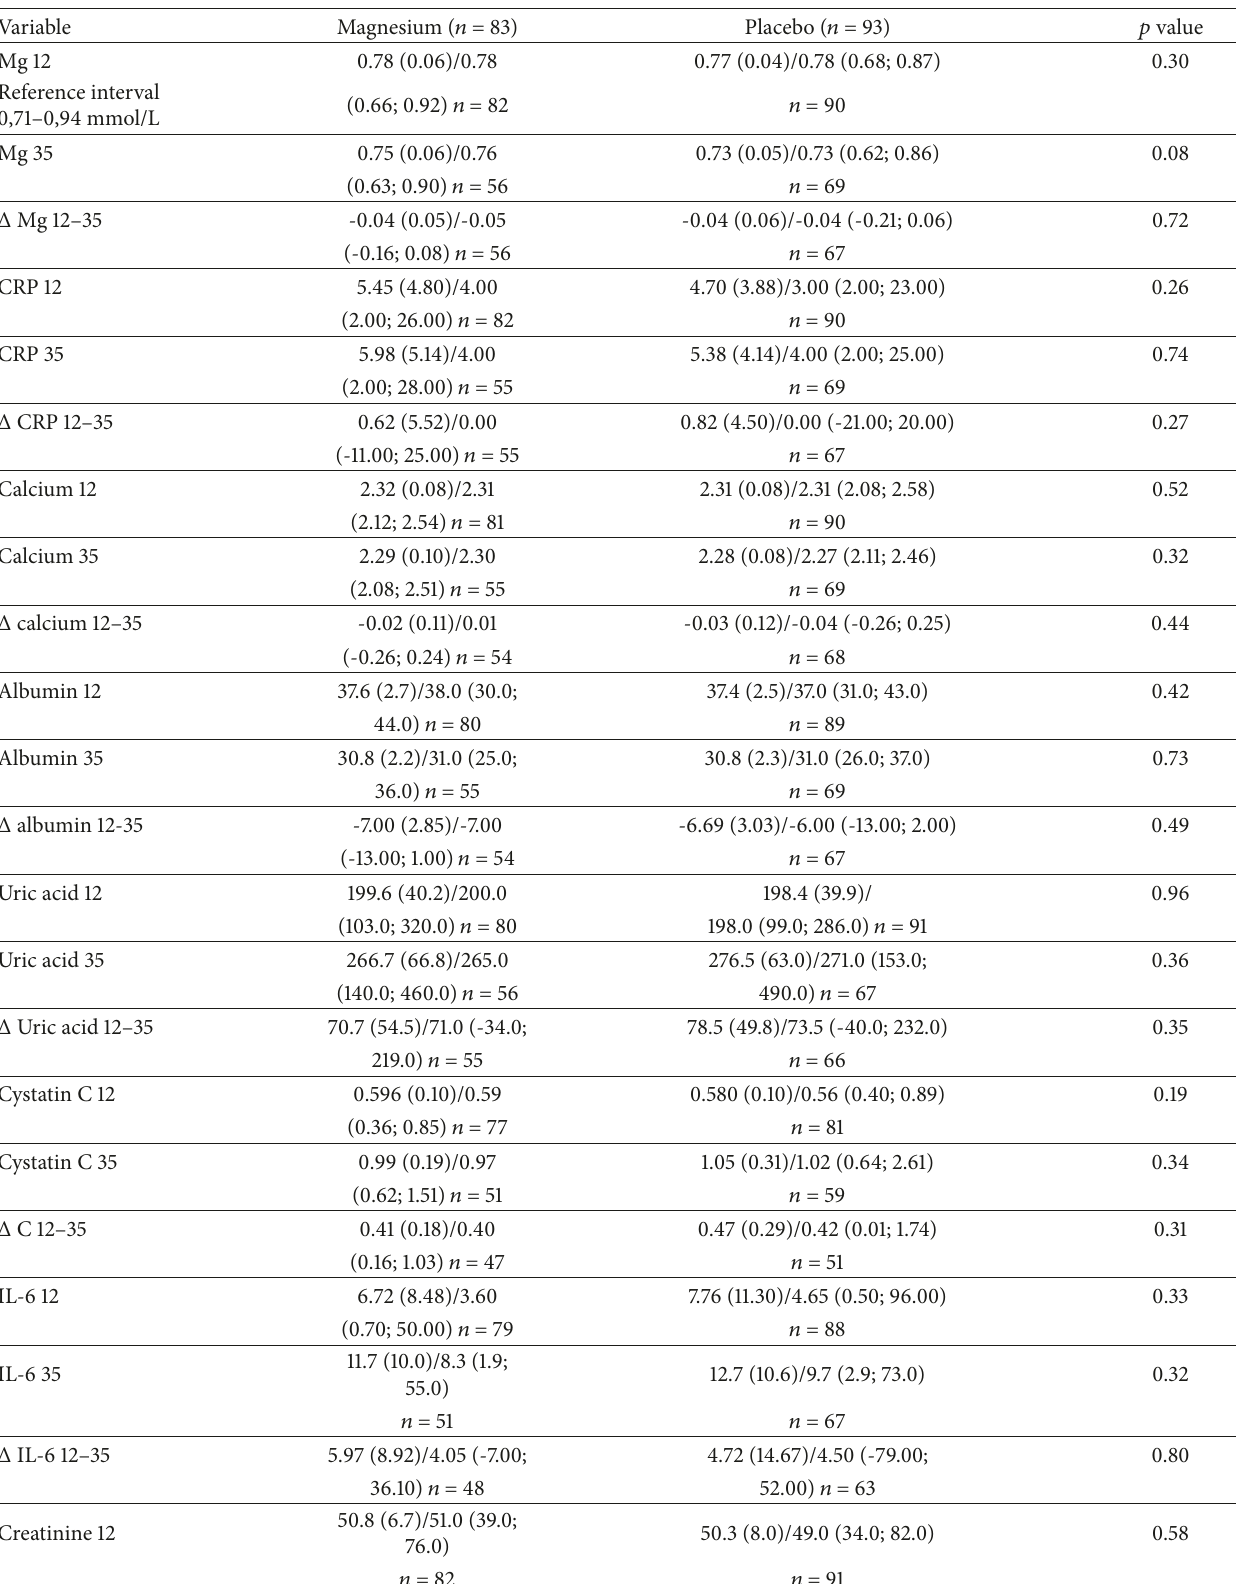
Table 4: Blood levels of Mg, CRP, calcium, albumin, uric acid, cystatin C, IL-6, creatinine, and glomerular filtration rate (GFR) at gestational weeks 12 and 35 and change in levels ( Δ ) from week 12 to week 35